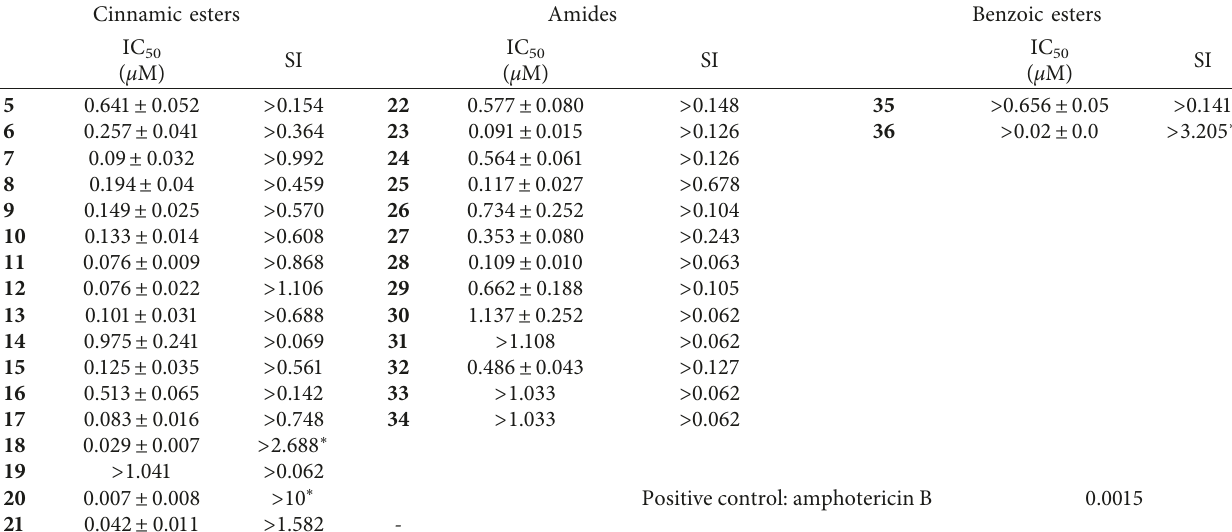
Table 1: Antileishmanial activity of compounds 5 – 36 against the strains IFLA/BR/1967/PH8 of Leishmania (L.) amazonensis. Cinnamic esters Amides Benzoic